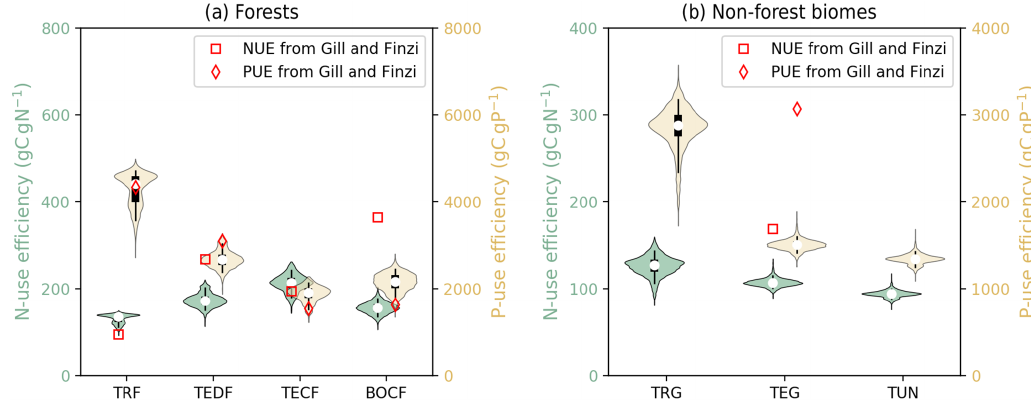
Figure 10. Violin plots of the nutrient-use efficiencies of the seven biomes from the experiment in which the allocation fraction of NPP to woody biomass and to leaves in coniferous forests is reduced. Open circles are the medians of all grid cells within each biome, with balloons representing the probability density distribution of each value. Black whiskers indicate interquartile (thick) and 95% confidence intervals (thin). The biomes are tropical rainforests (TRF), temperate deciduous forests (TEDF), temperate coniferous forests (TECF), boreal coniferous forests (BOCF), tropical/C 4 grasslands (TRG), temperate/C 3 grasslands (TEG), and tundra (TUN). The red squares (NUE) and diamonds (PUE) are the independent estimates from site observations and other generic data sets compiled and harmonized by Gill and Finzi (2016) based on site measurements of GPP and net N / P